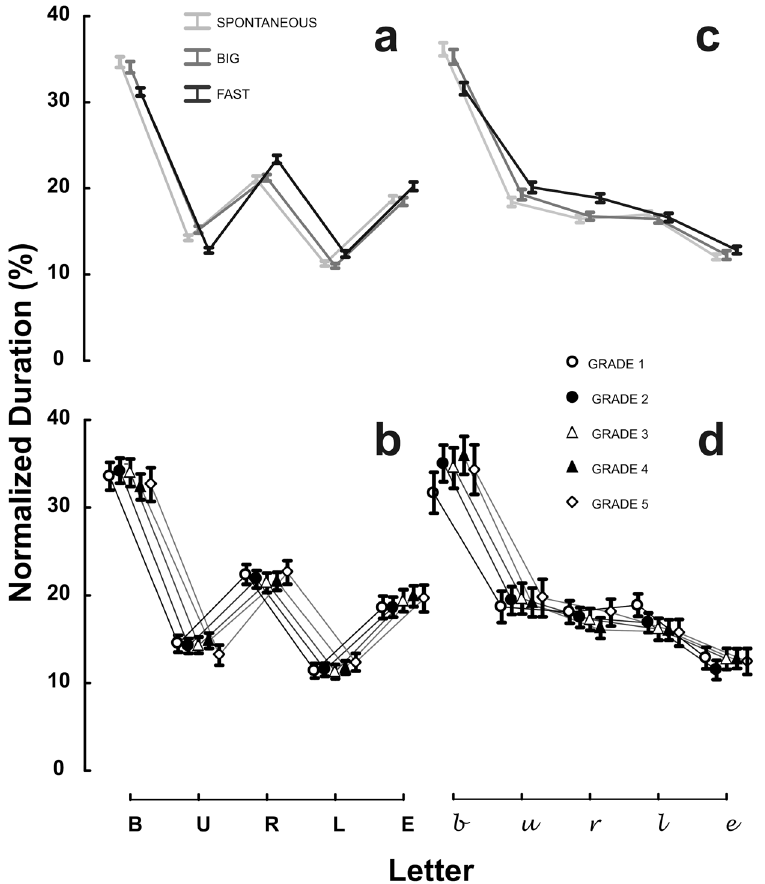
Figure 1. Homothety. The Condition ( Spontaneous , Big , Fast ) x Letter ( b , u , r , l , e ) (all-capital block script: Panel a; cursive: Panel c) and Group (G1, G2, G3, G4, G5) x Letter ( b , u , r , l , e ) (all-capital block script: Panel b; cursive: Panel d) interactions are shown for the percent duration taken to write each letter. Vertical error bars represent 95% confidence